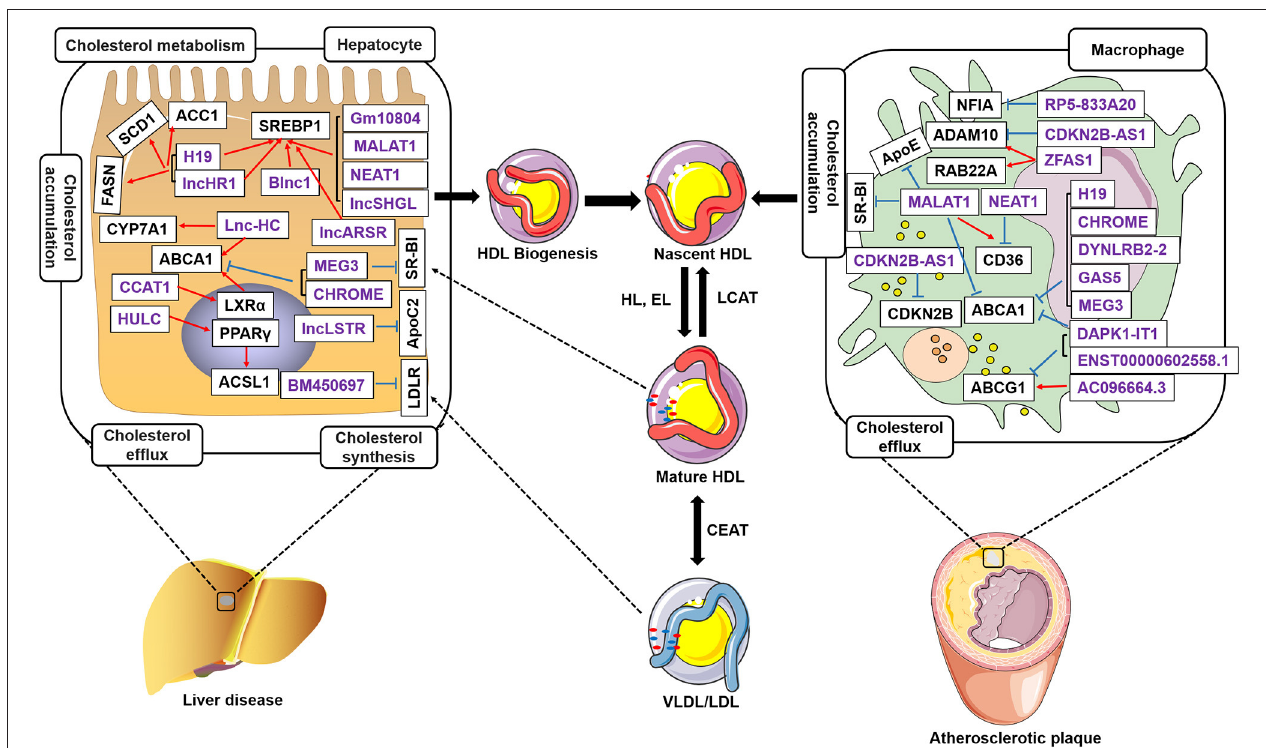
FIGURE 1 | LncRNAs regulate cholesterol homeostasis in hepatocytes and macrophages. LncRNAs in the liver regulate cholesterol accumulation, cholesterol efflux, cholesterol biosynthesis, and cholesterol metabolism. LncRNAs control cholesterol accumulation and cholesterol efflux in atherosclerotic plaques. LncRNAs regulate ABCA1 expression and inhibit cholesterol efflux to lipid poor apoA-I, which initiates nascent high-density lipoproteins (HDLs). LncRNAs control SREBP1, ACC1, SCD1, FASN, CYP7A1, and ACSL1 expression in hepatocytes. Meantime, lncRNAs also regulate NFIA, ApoE, CDKN2B, RAB22A, CD36, ABCG1, and ADAM10 expression in the macrophages accumulated in atherosclerotic plaques. Free cholesterol in the nascent HDL is further esterified to cholesteryl ester by lecithin-cholesterol acyltransferase (LCAT), which results in the formation of mature HDL particles. Purple indicates lncRNAs. Black represents the target genes regulated by LncRNAs. Blue, inhibit; Red,